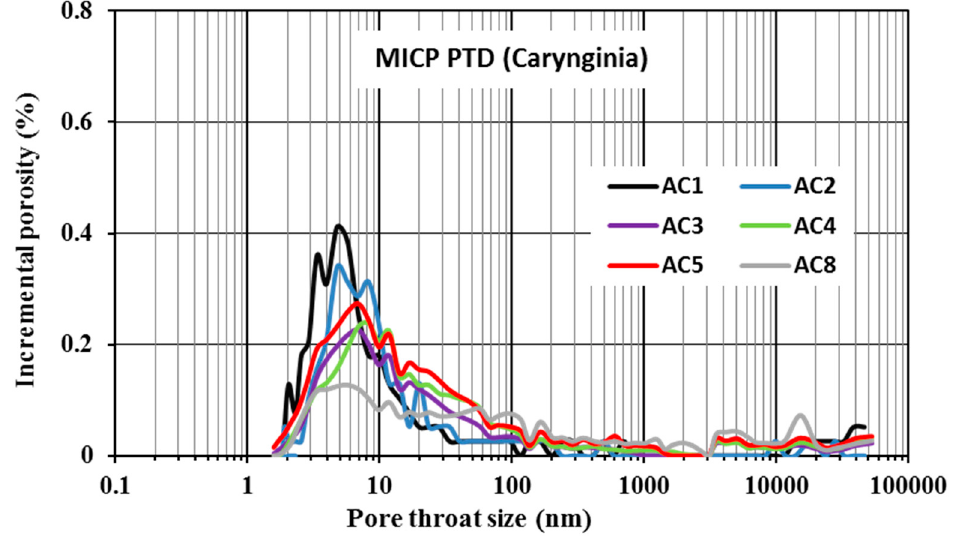
Figure 8. MICP pore throat size distribution (PTD) for Permian Carynginia shales.